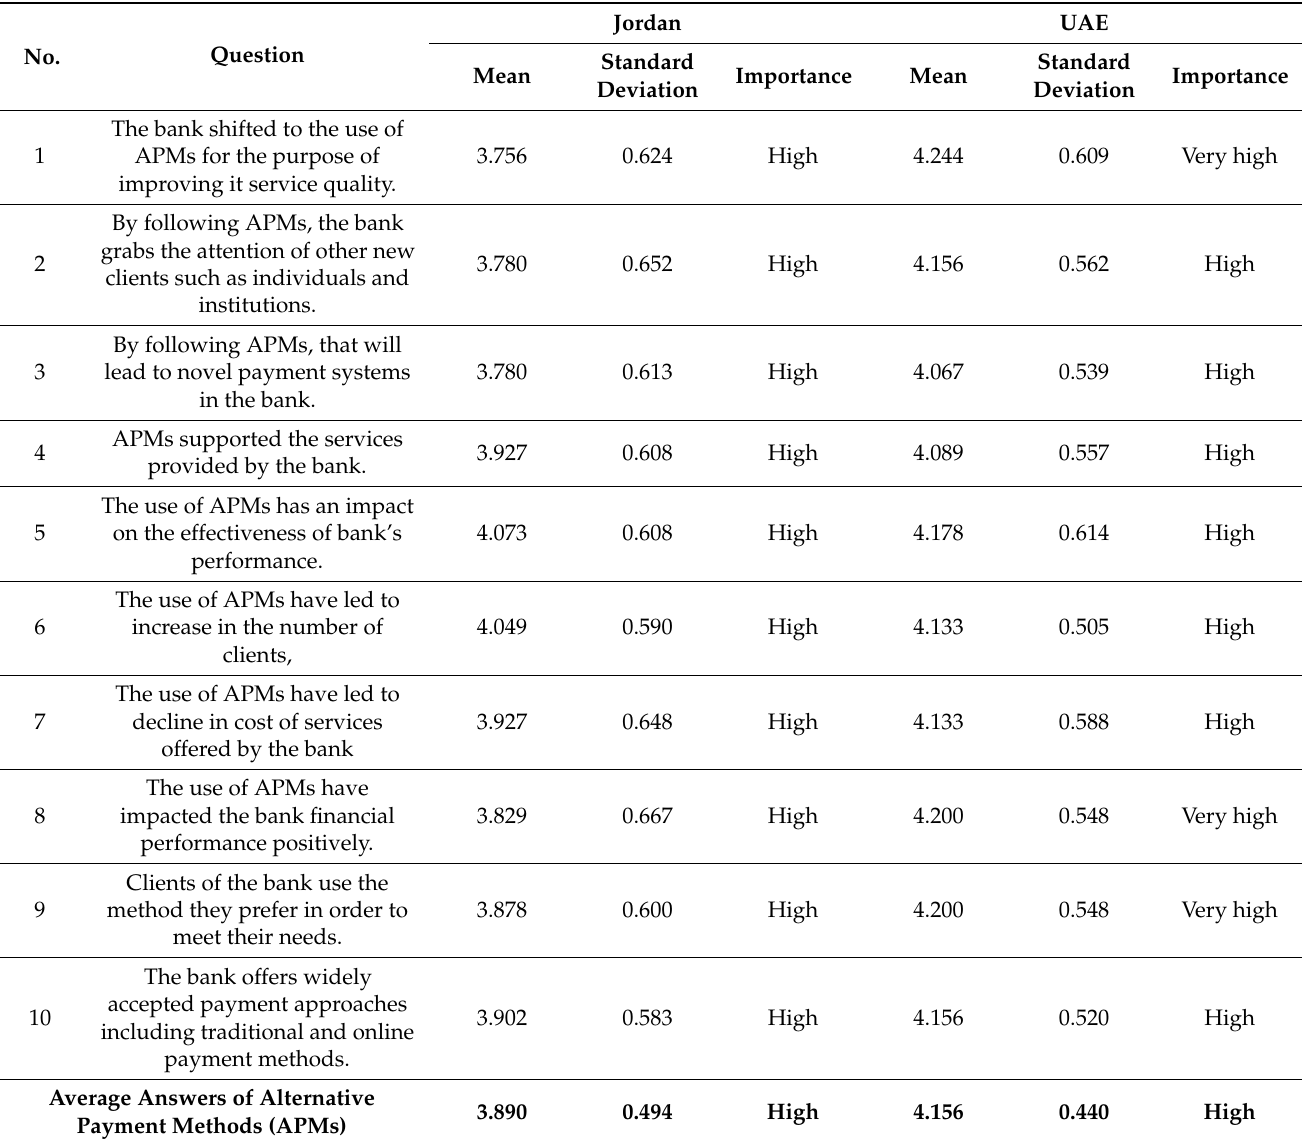
Table 3. Results of the Descriptive Analysis of the Independent Study Variable, Alternative Payment